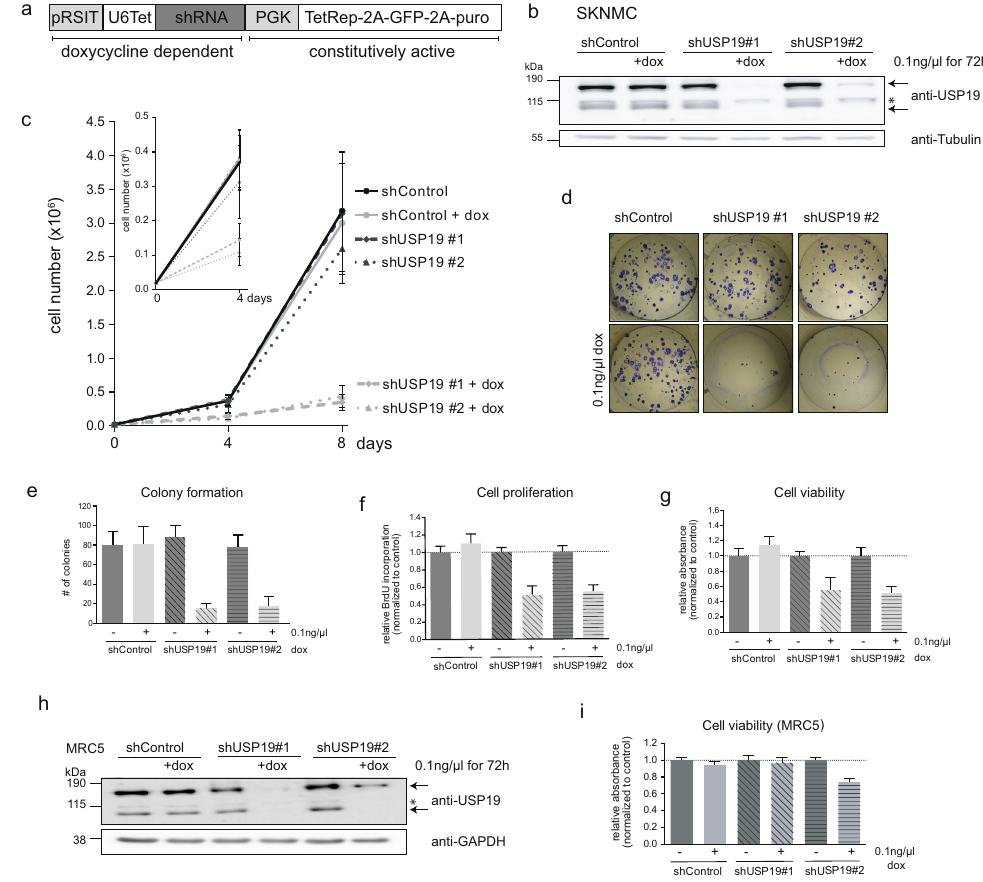
Figure 4. Depletion of USP19 affects Ewing sarcoma cell growth in vitro . ( a ) Scheme illustrating shRNA vector for stable transduction. The constitutively active part includes selection marker and a tetracycline repressive element. The doxycycline dependent part includes a tetracycline dependent promoter and the shRNA sequence. ( b ) SKNMC cells were stably transduced with two different shRNA sequences targeting USP19 and a control sequence (MOI = 5). After incubation with 0.1 ng/ µ l doxycycline for 72 h, USP19 protein levels were analyzed by western blotting using anti-USP19 antibody. Arrows indicate specific bands, asterisk marks unspecific band. ( c ) USP19 depletion affects cell growth. Knockdown of USP19 was induced in 2 × 10 4 SKNMC cells as indicated and cells were counted after 4 (smaller graph) and 8 days (larger graph). Total cell numbers were plotted from three independent experiments, error bars as SD. ( d ) Depletion of USP19 affects Ewing long-term cell survival. Doxycycline induced and non-induced SKNMC cells were plated to assess colony formation after 14 days. ( e ) Quantification of colonies from ( d ) represented as total counts of colony numbers (n = 3, error bars as SD). ( f , g ) Knockdown of USP19 affects cell proliferation and viability. Doxycycline induced and non-induced SKNMC cells were assessed for incorporation of BrdU or incubated with WST1 reagent ( g ) or both after 96 h. Values are shown relative to untreated shControl cells (n = 3, error bars as SD). ( h ,i) USP19 depletion has limited effect in unrelated non-tumorigenic cell lines. ( h ) MRC5 cells were transduced with two different shRNA sequences targeting USP19 and a control sequence and incubated with 0.1 ng/ µ l doxycycline for 72 h. USP19 protein levels were assessed by western blotting using anti-USP19 antibody, arrows indicate specific bands, asterisk marks unspecific band. (i) Doxycycline induced and non-induced MRC5 cells were assessed for cell viability by WST1 after 96 h (n = 3, error bars as